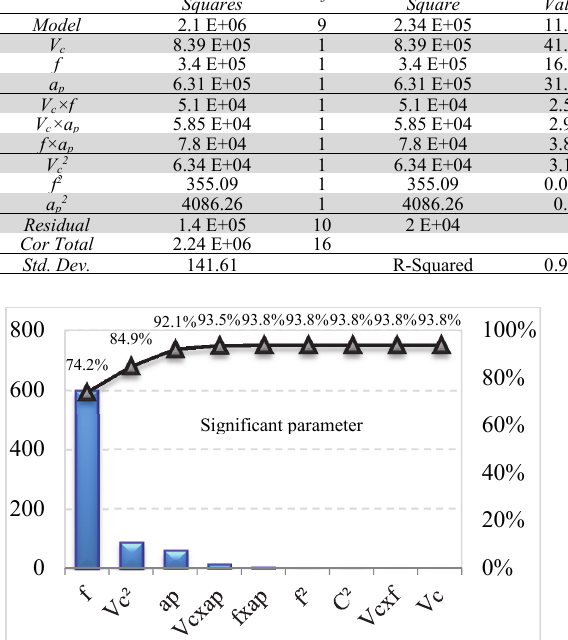
Analysis of variance for cutting power Source